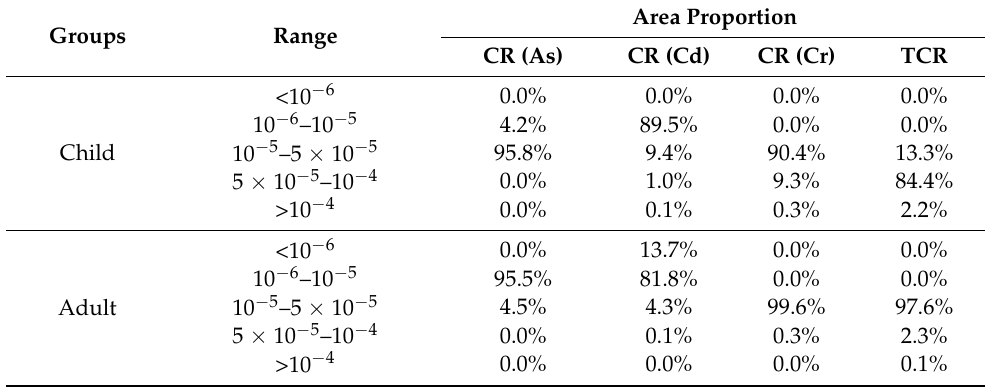
Table 9. Area proportion of carcinogenic